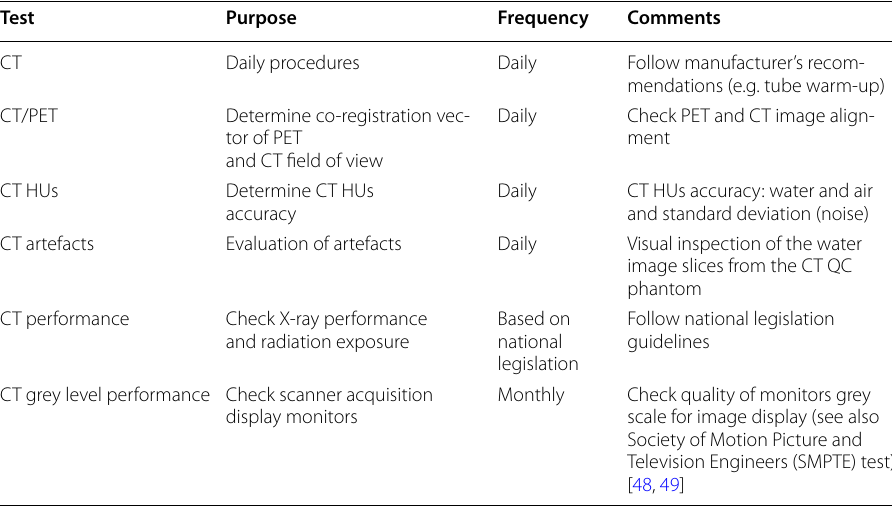
Modified, EANM Physics Group on Nuclear Medicine Instrumentation Quality Control 2010 [24,